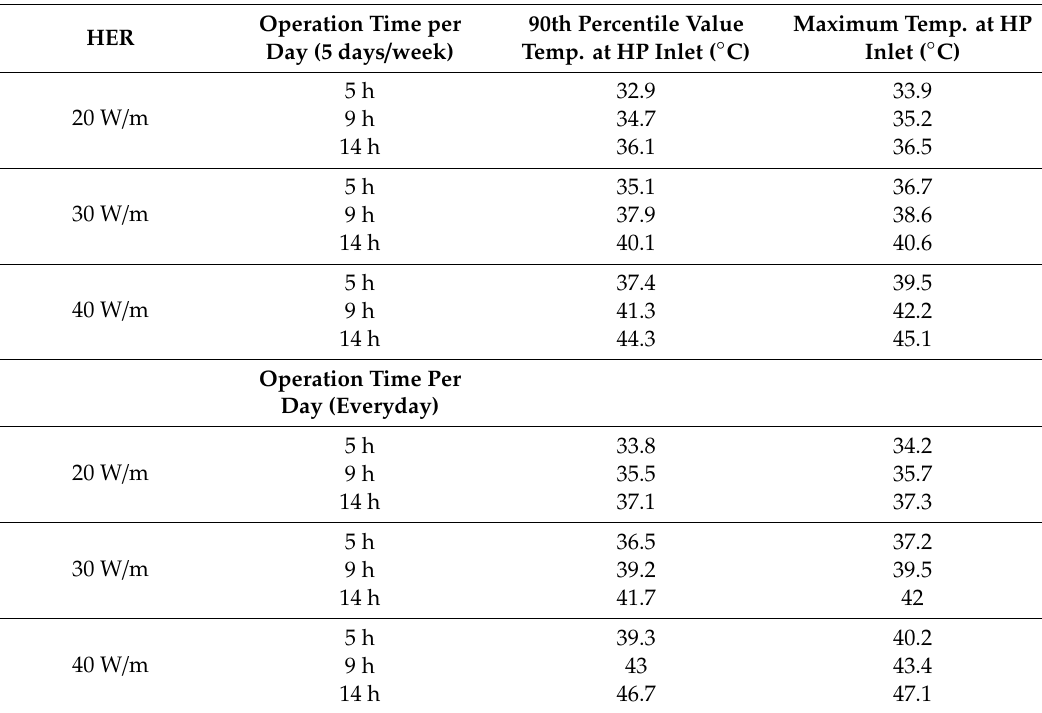
Table 5. The 90th percentile values and maximum temperatures at the HP inlet during the third year of operation. Operation Time per 90th Percentile Value Maximum Temp. at HP HER Day (5 days / week) Temp. at HP Inlet ( ◦ C) Inlet ( ◦ C) 5 h 32.9 33.9 20 W / m 9 h 34.7 35.2 14 h 36.1 36.5 5 h 35.1 30 W / m 37.9